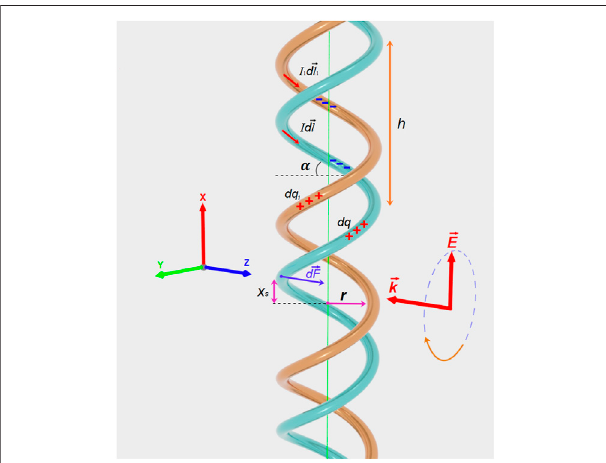
FIGURE 1 | Schematic of an asymmetric double-stranded helix (DNA- liketype)inthe fi eldofanincidentelectromagneticwavewithleft-handcircular polarization. The helix pieces with the maximum concentration of electric currents and charges are indicated for the type of excitation studied. It is assumed that the electric currents in two strands are in the same direction relativetothehelixaxis.AnumericalsimulationofadoubleDNA-likehelixasan ideal conductor con fi rmed this assumption about the direction of the currents at high-frequency resonance, see Section 8 .